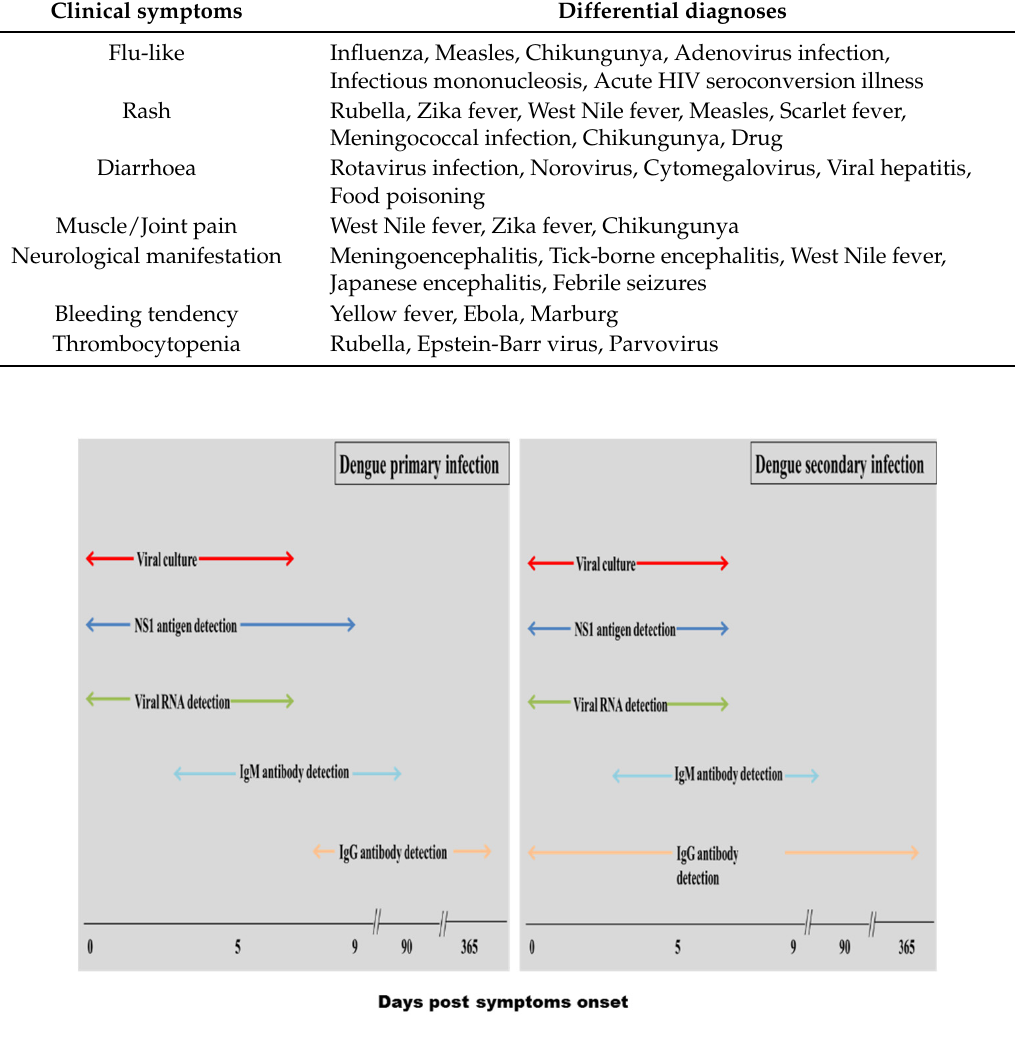
Figure 1. Suitability of dengue diagnostics at different phases of illness.